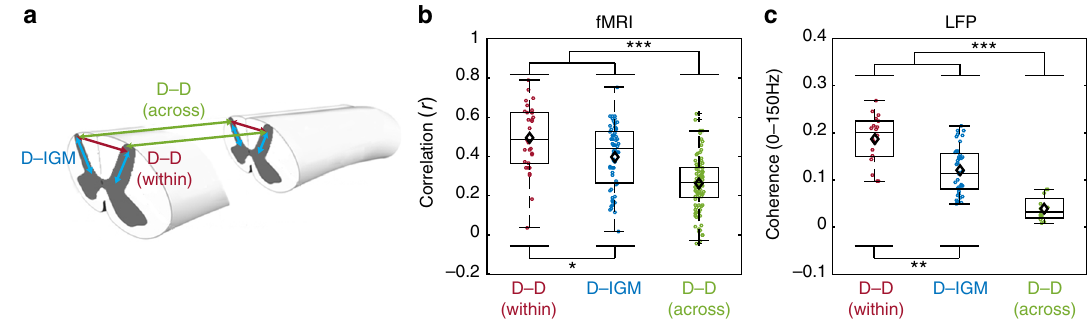
Fig. 5 Comparison between resting-state fMRI and LFP connectivities. a Schematic diagram of correlation and coherences computed in the recordings of the spinal cord. b , c Group averaged within and across segments dorsal to dorsal (D – D) as well as dorsal to intermediate GM (D – IGM) connectivity was computed. Group boxplots of connectivity measures are displayed as Pearson ’ s correlation for fMRI and averaged coherences for LFP. Each boxplot contains fMRI observations from 12 monkeys (including those that underwent electrophysiology) across 15 functional studies, and electrophysiology observations from four monkeys in panels b and c , respectively. Ipsilateral dorsal-to-intermediate GM from the left and right hemi-cord was concatenated. The median and mean are represented as horizontal lines and diamonds, respectively, in each boxplot. Scatter circles on each boxplot represent individual observations. Using mean connectivity values from the three ROI pairs from both modalities ( b , c ), Pearson ’ s correlation value was computed to be 0.9982. * p < 0.05, ** p < 0.0005, and *** p < 0.00005 Bonferroni – Holm corrected two-sided Mann – Whitney